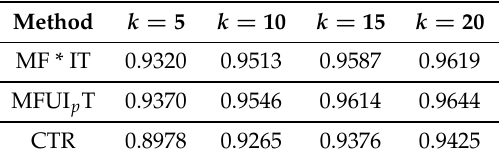
Table 4. Movie recommendation performance using rank-based metric normalized discounted cumulative gain (NDCG) at top K